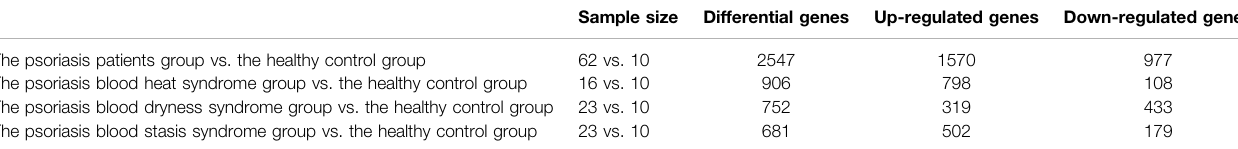
TABLE 1 | Analysis of differentially expressed genes between groups. The psoriasis patients group vs. the healthy control group